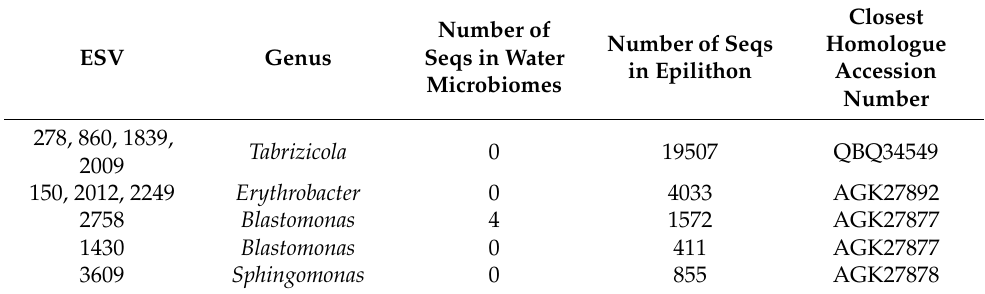
Table 4. Alpha-diversity of pufM -containing microbial communities of epilithon (G51, G52, BK51, BK53), neuston (BK1, G1), and plankton (BK2, BK4, G2, G4) of Lake Baikal. BK—samples taken off the Bol’shiye Koty settlement; G—samples taken off the Bol’shoye Goloustnoye settlement. Microbial Community S.chao1 Shannon